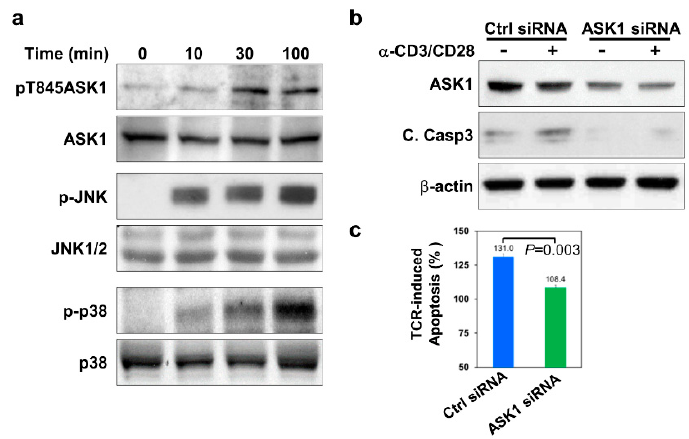
Figure 1. ASK1 is activated and involved in the apoptosis of thymocytes upon TCR stimulation. ( a ) Activation of ASK1 and JNK / p38 in thymocytes upon TCR-engagement. Thymocytes were stimulated with anti-CD3 (10 µ g / mL) and anti-CD28 (1 µ g / mL) antibodies for various periods of time, as indicated. Whole cell lysates were prepared and subjected to immunoblotting to examine the phosphorylation status of ASK1 at Thr845, JNK at Thr183 / Tyr185, and p38 at Thr180 / Tyr182, respectively. The amount of ASK1, JNK1 / 2, and p38 was also detected and included as loading controls for the individual protein. ( b ) Knockdown of ASK1 and its e ff ect on TCR-induced caspase-3 activation in thymocytes. Thymocytes were transfected with control siRNA (ctrl siRNA) or ASK1-specific siRNA (ASK1 siRNA), followed by culture without or with anti-CD3 (10 µ g / mL) and anti-CD28 (1 µ g / mL) antibodies for 16 h. Whole cell lysates were prepared and subjected to immunoblotting for the detection of ASK1 and the activated or cleaved form of caspase-3. An anti- β -actin blot was included as the loading control. ( c ) Suppression of TCR-induced apoptosis of thymocytes by ASK1 knockdown. Thymocytes were transfected with ctrl siRNA or ASK1 siRNA and treated with anti-CD3 (10 µ g / mL) and anti-CD28 (1 µ g / mL) antibodies for 16 h. Cells were harvested and stained with Annexin V and propidium iodide (PI), followed by a flow cytometric analysis. The percentage of TCR-induced apoptosis of thymocytes was expressed as: (percentage of dead cells with TCR treatment - percentage of dead cells without TCR treatment) / percentage of dead cells without TCR treatment. The data shown are representative of more than three independent experiments ( a , b ). The bar graph is shown as the mean ± SD ( n = 3).